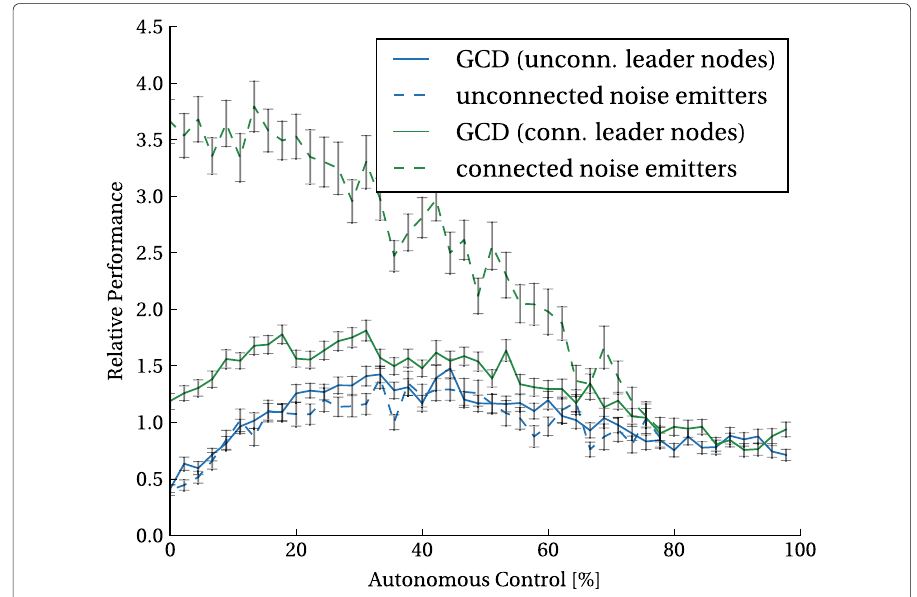
Fig. 5 Relative performance for the GCD model (solid lines) and the derived model of noise emitting leader nodes (dashed lines) shown in comparison. N = 60, χ = 4, s =